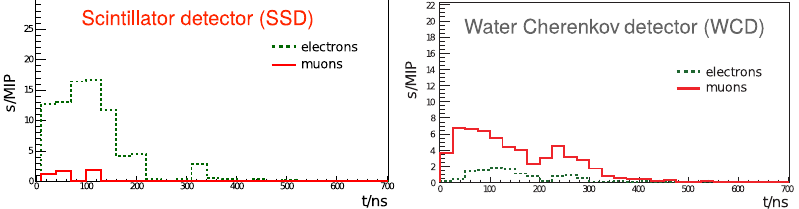
Figure 2: Detector response of electrons and muons for SSD (left panel) and WCD (right